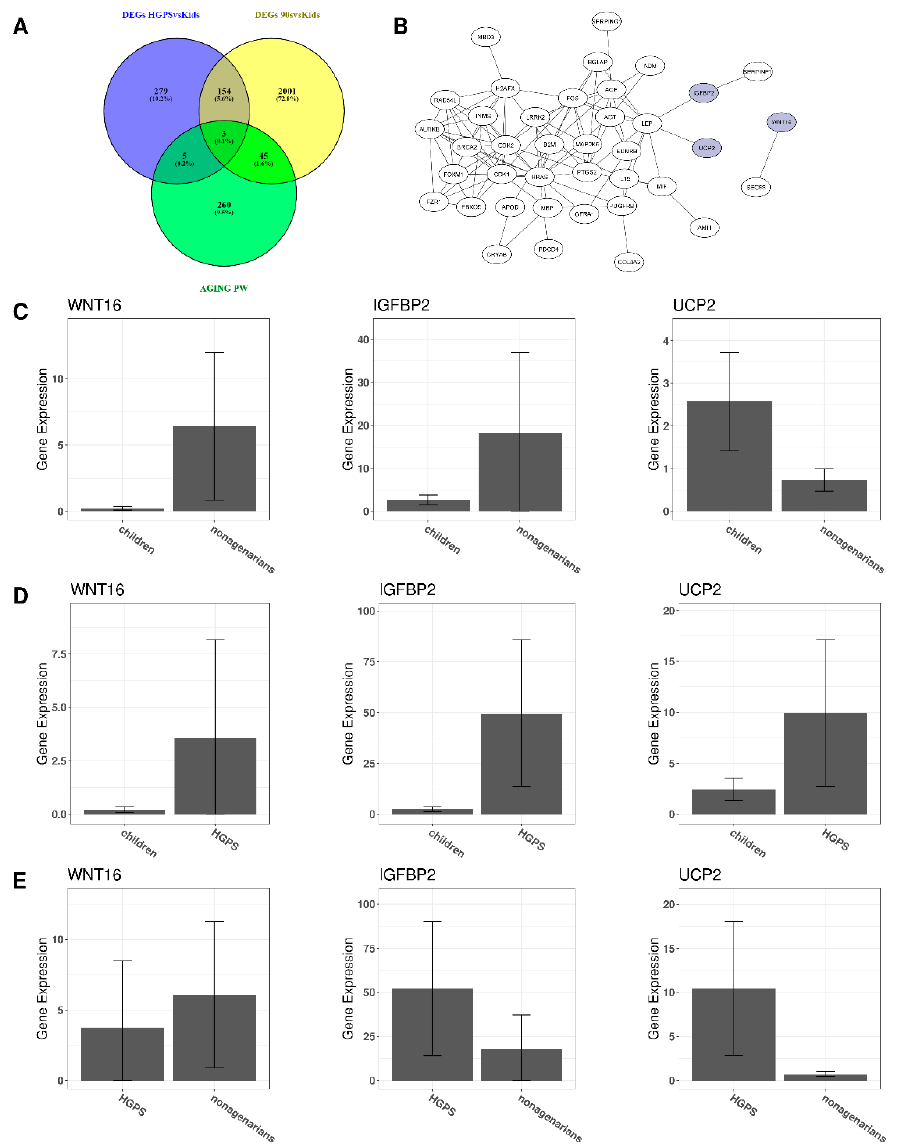
Figure 6. Network visualization of miRNAs related to WNT16, IGFBP2, and UCP2. ( A ) Comparing the genes involved in the Aging Pathway (green) with the DEGs in progeria comparison (blue) and the aging comparison (yellow) results in three common DEGs WNT16, IGFBP2, and UCP2. ( B ) Network visualization of the DEGs involved in the aging pathway and differentially expressed between healthy children and nonagenarians. The three DEGs that are also differentially expressed when comparing progeria patients and nonagenarians are highlighted in purple. ( C ) Gene expression of the three DEGs WNT16, IGFBP2, and UCP2, when comparing children and nonagenarians. ( D ) Gene expression of the three DEGs WNT16, IGFBP2, and UCP2, when comparing children and HGPS phasents. ( E ) Gene expression of the three DEGs WNT16, IGFBP2, and UCP2, when comparing progeria patients and nonagenarians.